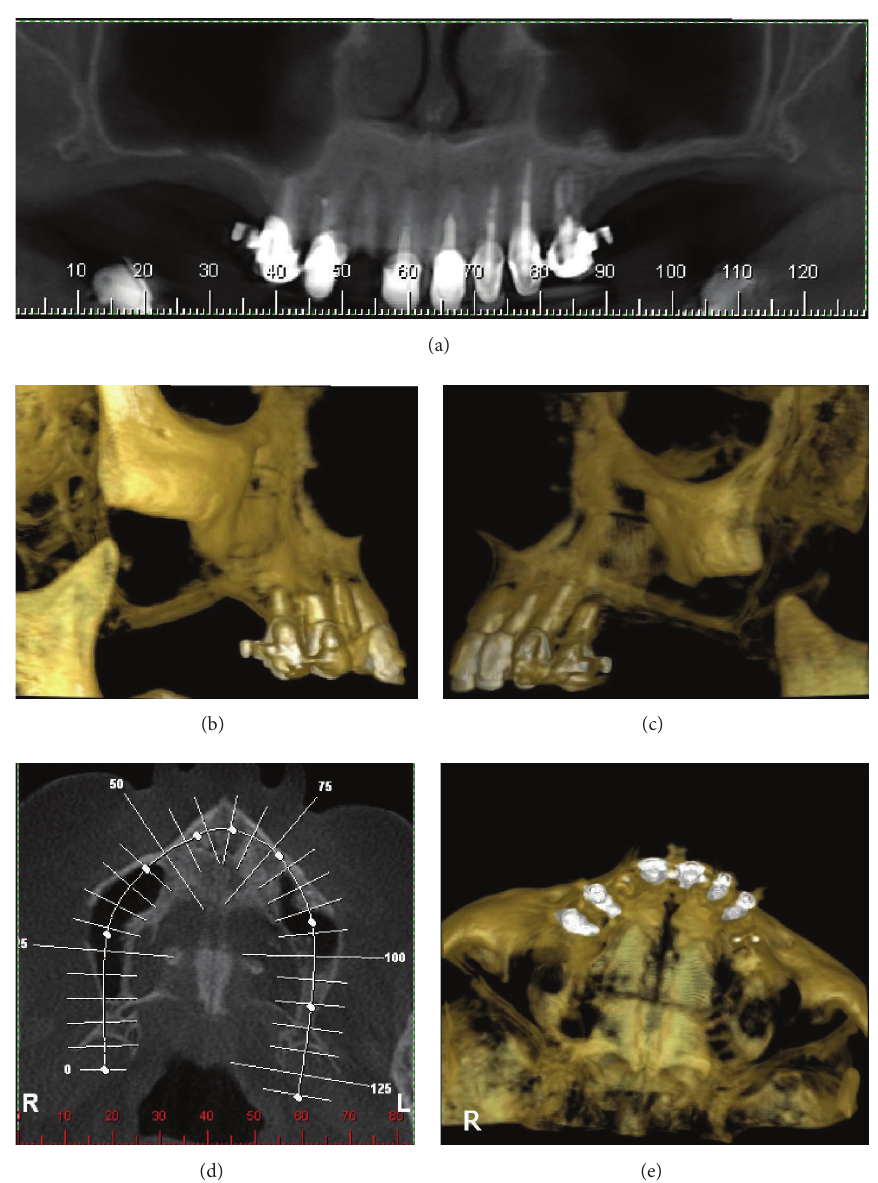
Figure 3: (a) Panoramic view showing a healthy maxillary sinus cavity after 12 months. (b), (c) Tridimensional reconstruction computed tomography scan showing preserved bony structures. (d) and (e) Occlusal slice showing unobstructed maxillary sinus